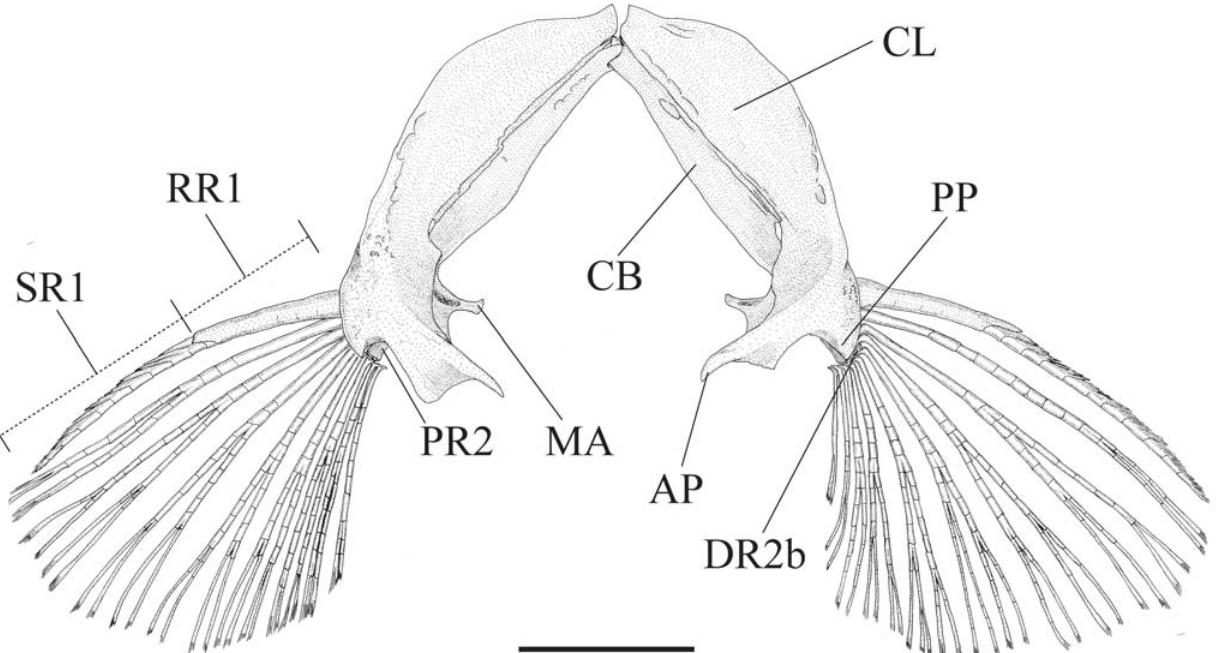
Fig. 8. Pectoral girdle and fins of Rhamdiopsis krugi , LIRP 5928, 33.9 mm SL, paratype. Dorsal view. AP ) articular cleithral process; CB ) posterior complex bone of pectoral girdle (scapula, coracoid, and mesocoracoid fused); CL ) cleithrum; DR2b